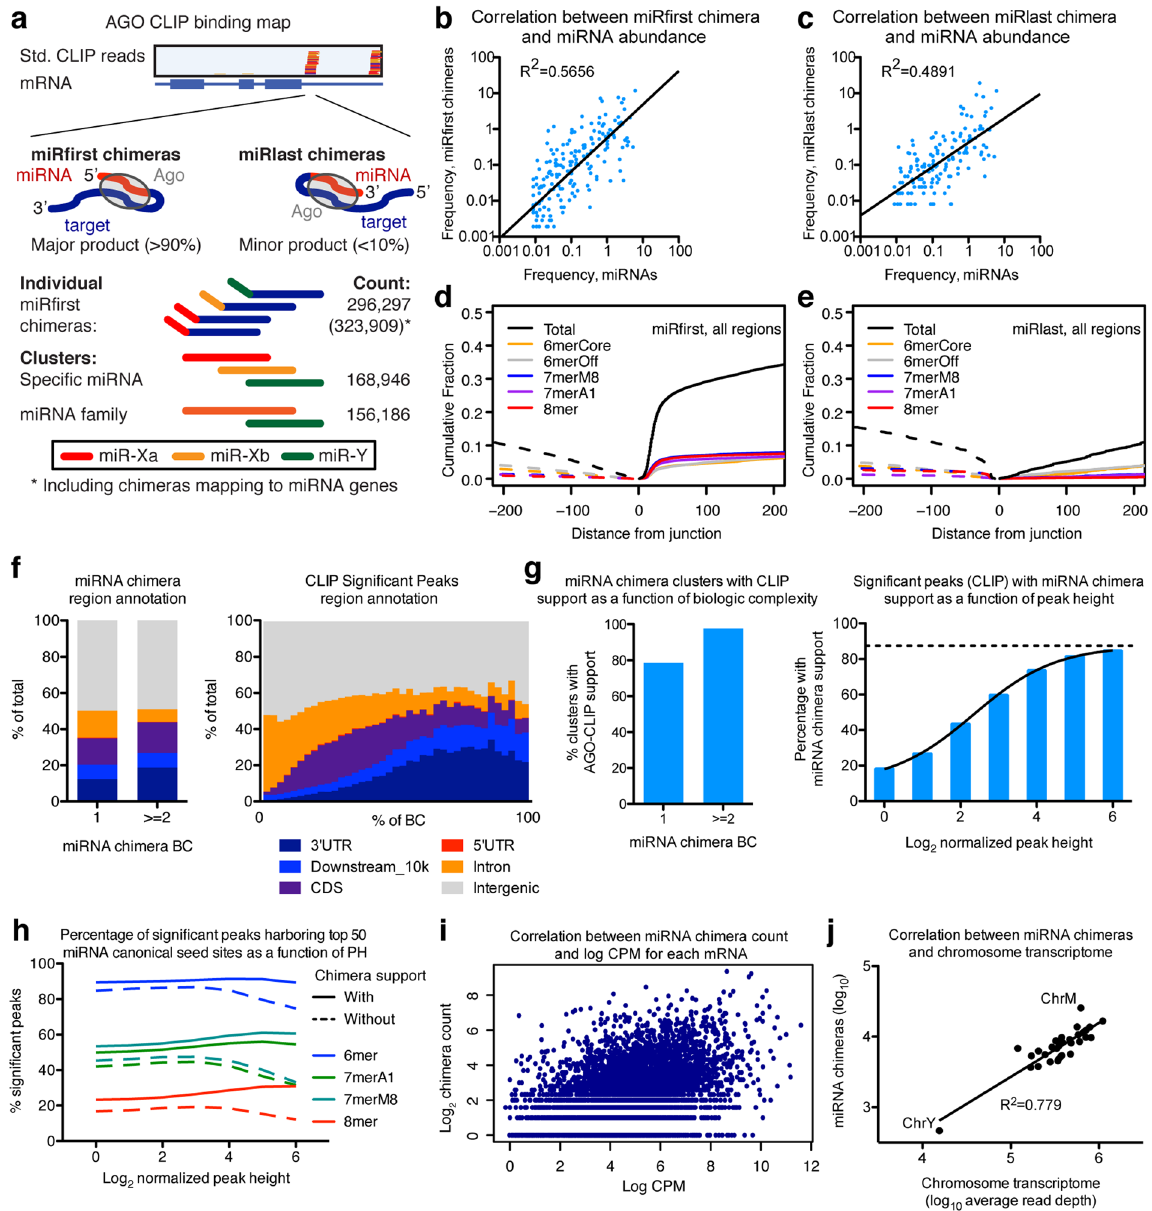
Figure 1. Identification and characterization of miRNA-target chimeras. (a) Schematic representation of AGO-CLIP reads mapping to an mRNA and of the two types of miRNA-target chimeras, miRfirst and miRlast (top). Schematics and numbers of individual chimeras, clusters, and family clusters (bottom). (b , c) Correlation between frequencies of AGO-loaded miRNA-chimeras and individual miRNAs for miRfirst ( b ) and miRlast ( c ) chimera types. (d , e) Cumulative plots showing enrichment for canonical miRNA seed sites upstream and downstream in target sequences relative to the chimeric junction site. (f) Genomic region annotation for miRNA chimeras (left) or for significant CLIP peaks (right) as a function of BC. (g) Overlap between miRNA chimera and standard CLIP data shown as a function of miRNA chimera BC (left) or as a function of normalized height for significant CLIP peaks (right). (h) Percentage of significant peaks harboring top 50 miRNA canonical seed sites as a function of peak height (PH) is shown for chimera supported and non- supported peaks. (i) Correlation between miRNA chimera count and log(CPM) for each mRNA. (j) Correlation between miRNA chimera count and chromosome transcriptome